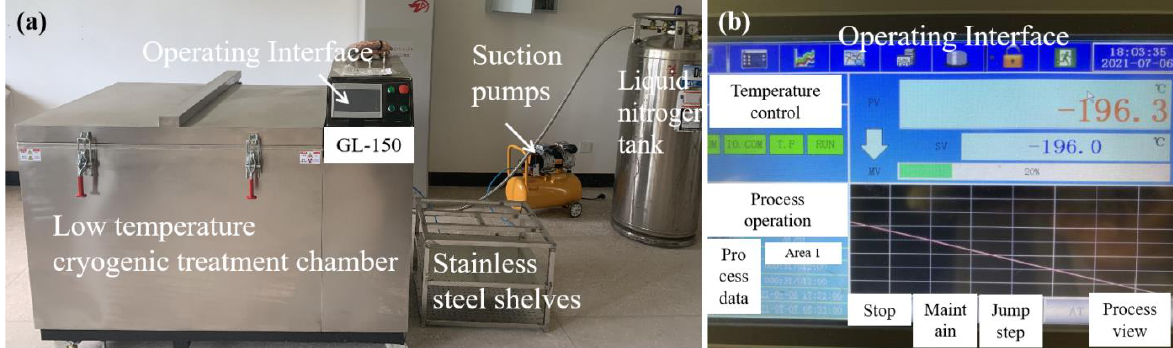
Figure 2. ( a ) Cryogenic treatment chamber, and ( b ) cryogenic treatment real time display interface.